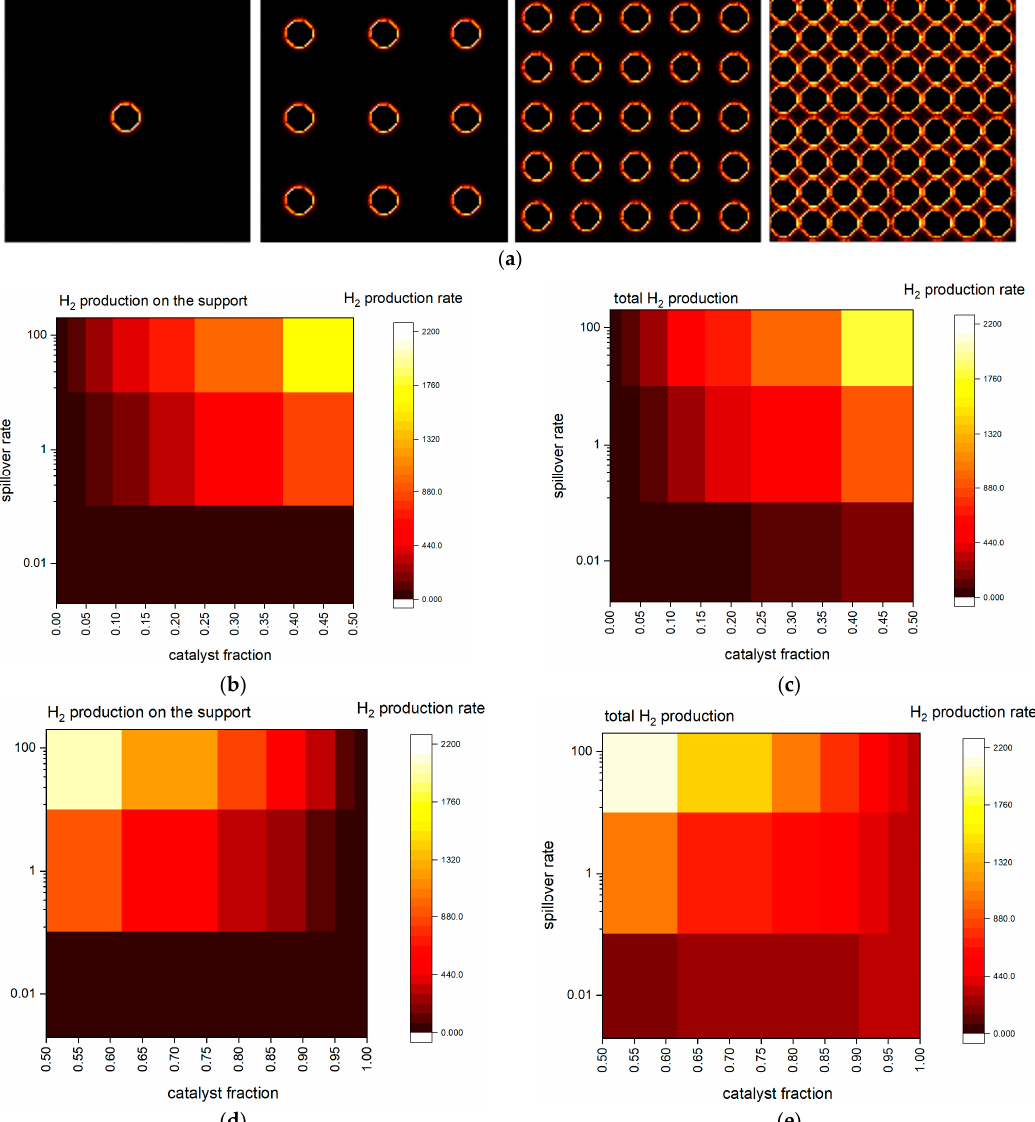
Figure 2. ( a ) Spatial distribution of H 2 production in the system with slow Heyrovsky reaction with different coverage of catalyst phase (brighter color stands for more intense H 2 production), the systems were generated on a two-dimensional lattice with 130 points in x and y directions (distance between the points is dimensionless). Heatmaps for H 2 production when the Heyrovsky reaction is slow as a catalyst coverage and the spillover rate: ( b ) production from the support for the C@S configuration; ( c ) total production for the C@S configuration; ( d ) production from the support for the S@C configuration; ( e ) total production for the S@C configuration. While increasing the spillover rate, the production of H 2 from the S phase increases, and the H ads coverage on the metal phase decreases. For the C@S configuration, the overall production increases with the catalyst fraction and reaches the maximum for the metal coverage of 0.5 ML. On the other side, the overall production for the S@C configuration decreases with the catalyst fraction, and it is maximal for the catalyst fraction of 0.5 ML.